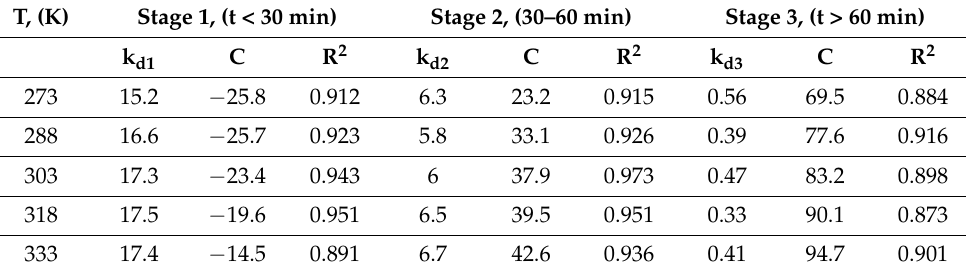
Table 5. IPD parameters for the adsorption of AZM on AFAC.